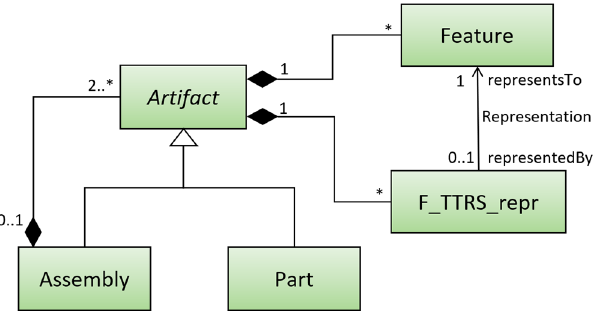
Figure 5. Abstract syntax of artifact definition (“*” is a “zero to many” multiplicity).